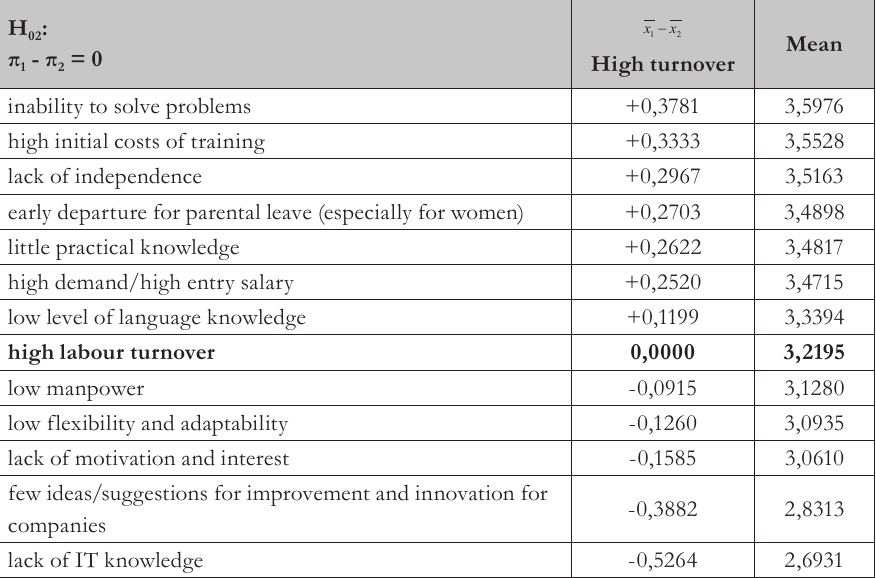
Tab. 1 – Matrix evaluation of risk factors to the tested factor: “high turnover”. Source: own H 0